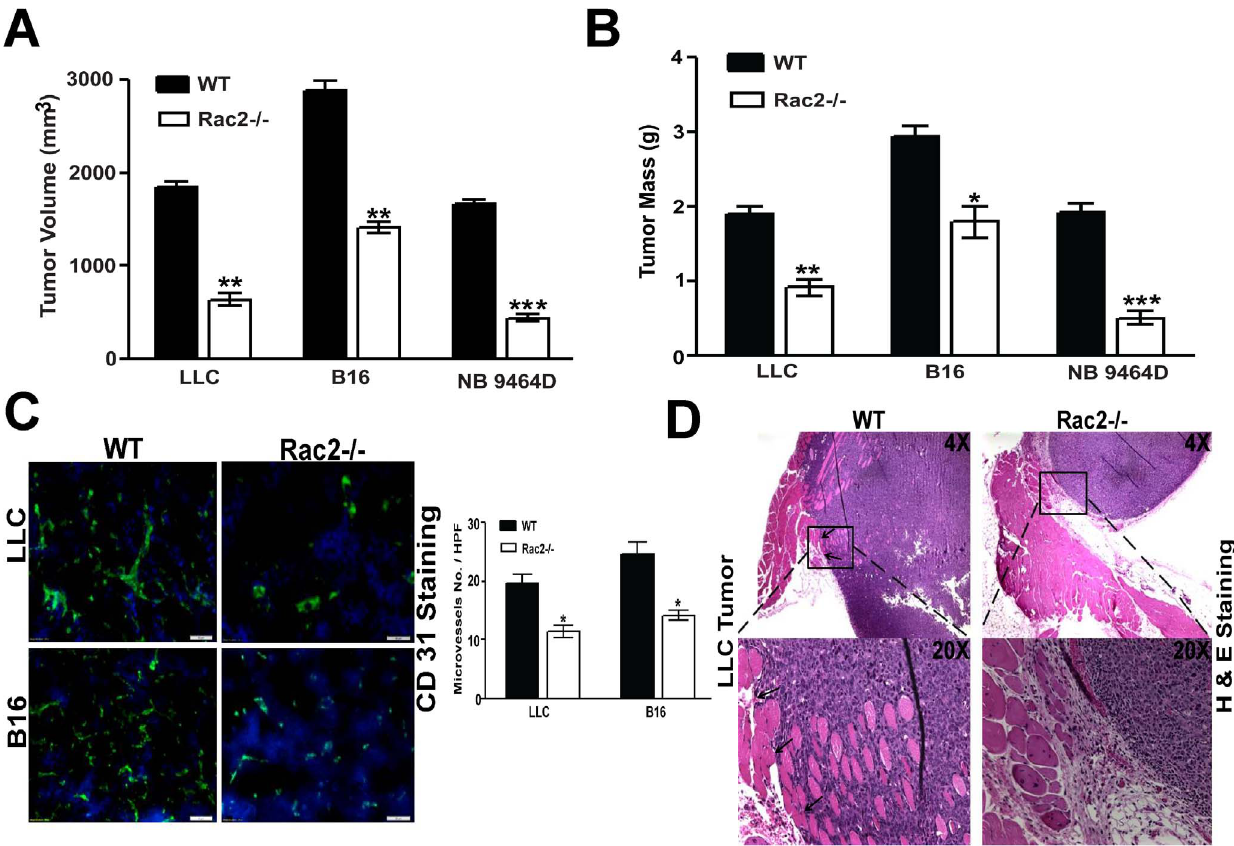
Figure 1. Rac2 promotes tumor growth, angiogenesis and invasion. (A & B) WT and Rac2-/- mice (n=8-10) were subcutaneously implanted with 1 6 10 5 LLC, B16F10 and 2 6 10 6 NB9464D cells on the dorsal flank. Tumor growth was monitored regularly, until tumors were harvested on day 21. Mean tumor volume (A) and mass (B) for each group (n=8) is plotted. Graphs present mean 6 SEM of 8 mice in each group. Statistical significance is assessed by two sample t -test where *denotes P , 0.05, ** denotes P , 0.01 and *** denotes P , 0.001. Experiment was repeated 7–8 times with similar results. (C) Left panel shows representative immunofluorescent staining of tumor vasculature by CD31 (green) and counterstain by DAPI (blue) on frozen tumor sections of LLC and B16 tumors implanted subcutaneously in WT and Rac2-/- mice. Right panel shows reduced microvascular density (MVD) in tumors isolated from Rac2-/- animals as compared to WT animals. MVD was determined by counting the number of microvessels per high-power field (HPF) in the section with an antibody reactive to CD31. Microvessels were counted blindly in 5–10 randomly chosen fields and data is representative of three independent experiments with 4–5 mice. * P , 0.05 vs. WT. (D) H & E stained images (magnification 4X and 20X) showing invasive interface between the skin and muscularis layer of subcutaneous implanted LLC tumor into WT and Rac2-/- animals. The invasive interface is shown by arrows. Same results were obtained with 7–8 mice in each group and experiment is repeated 7–8 times.